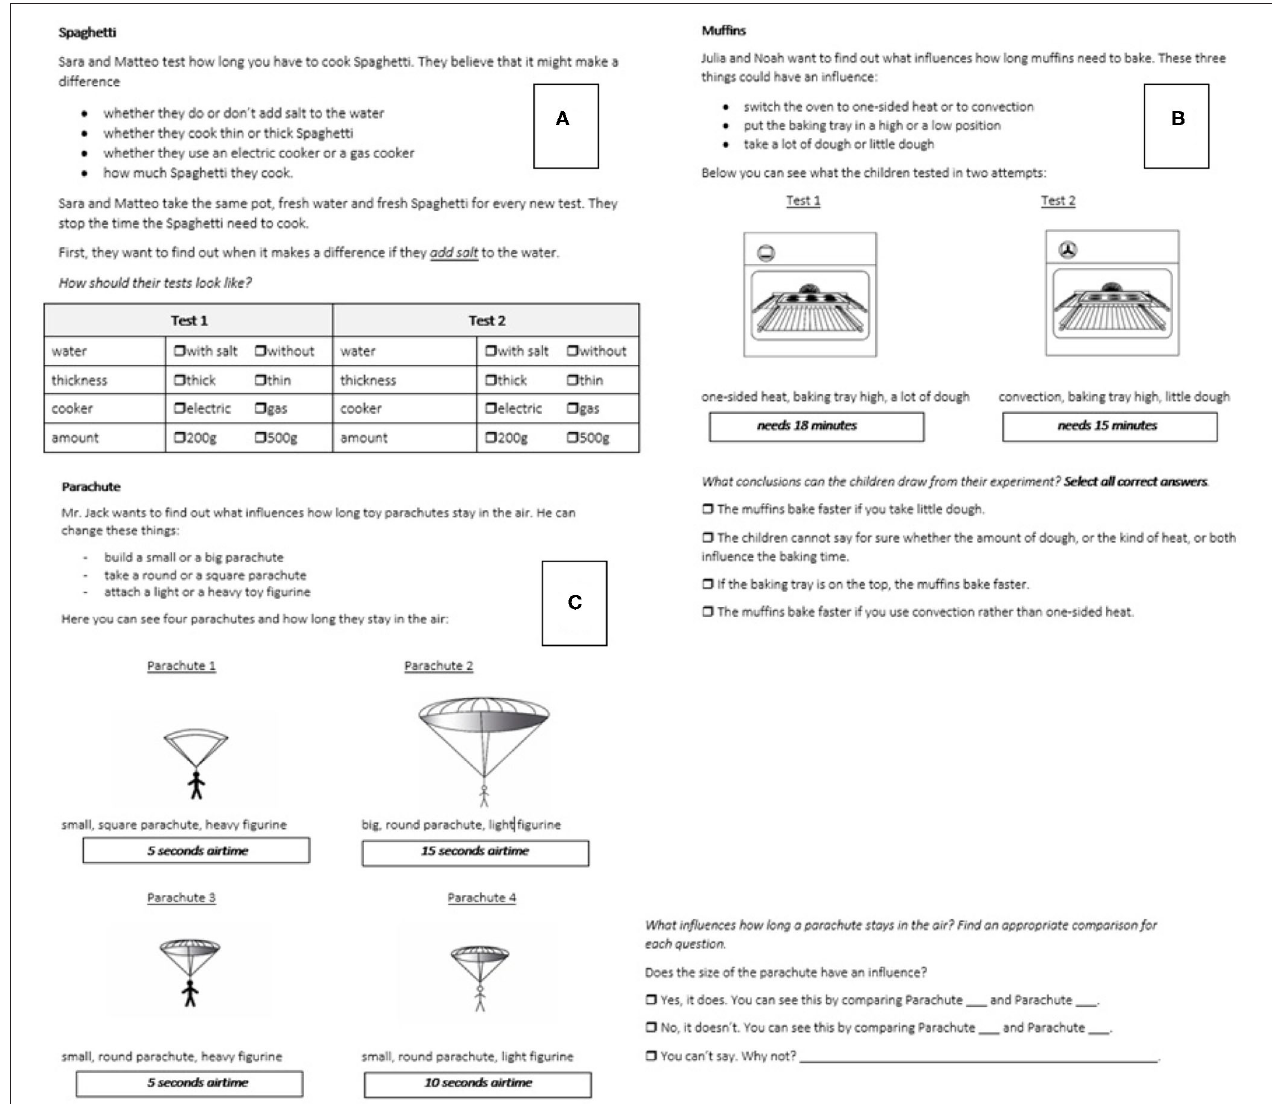
FIGURE 2 | Example items for the assessment of each sub-skill of CVS. The items on top assess the sub-skills planning (A) and understanding (B) . The item at the bottom (C) assesses the sub-skills interpreting and identifying